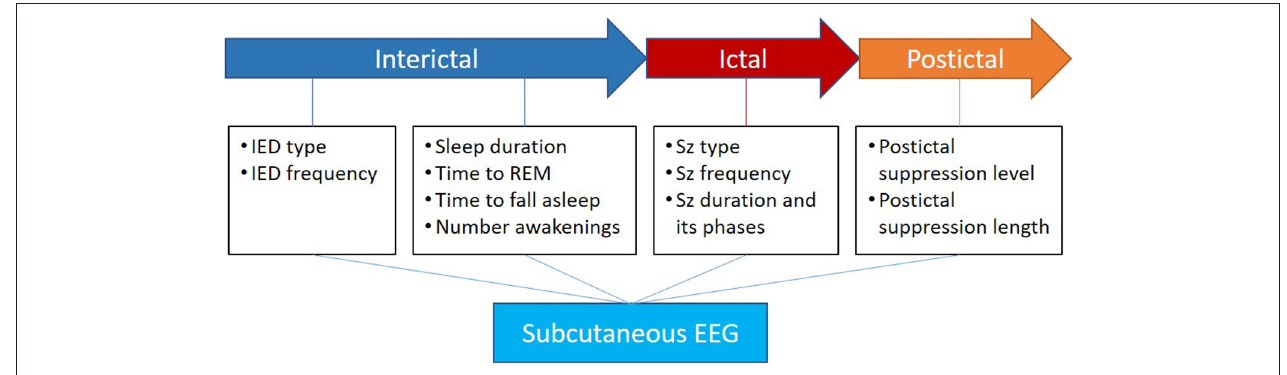
FIGURE 2 | Apart from the direct value of ictal electrographic seizure description, the subcutaneous EEG has the potential to add valuable knowledge in the interictal phase about IEDs and sleep as well as the postictal phase about suppression level and length. Inspired by Beniczky et al.